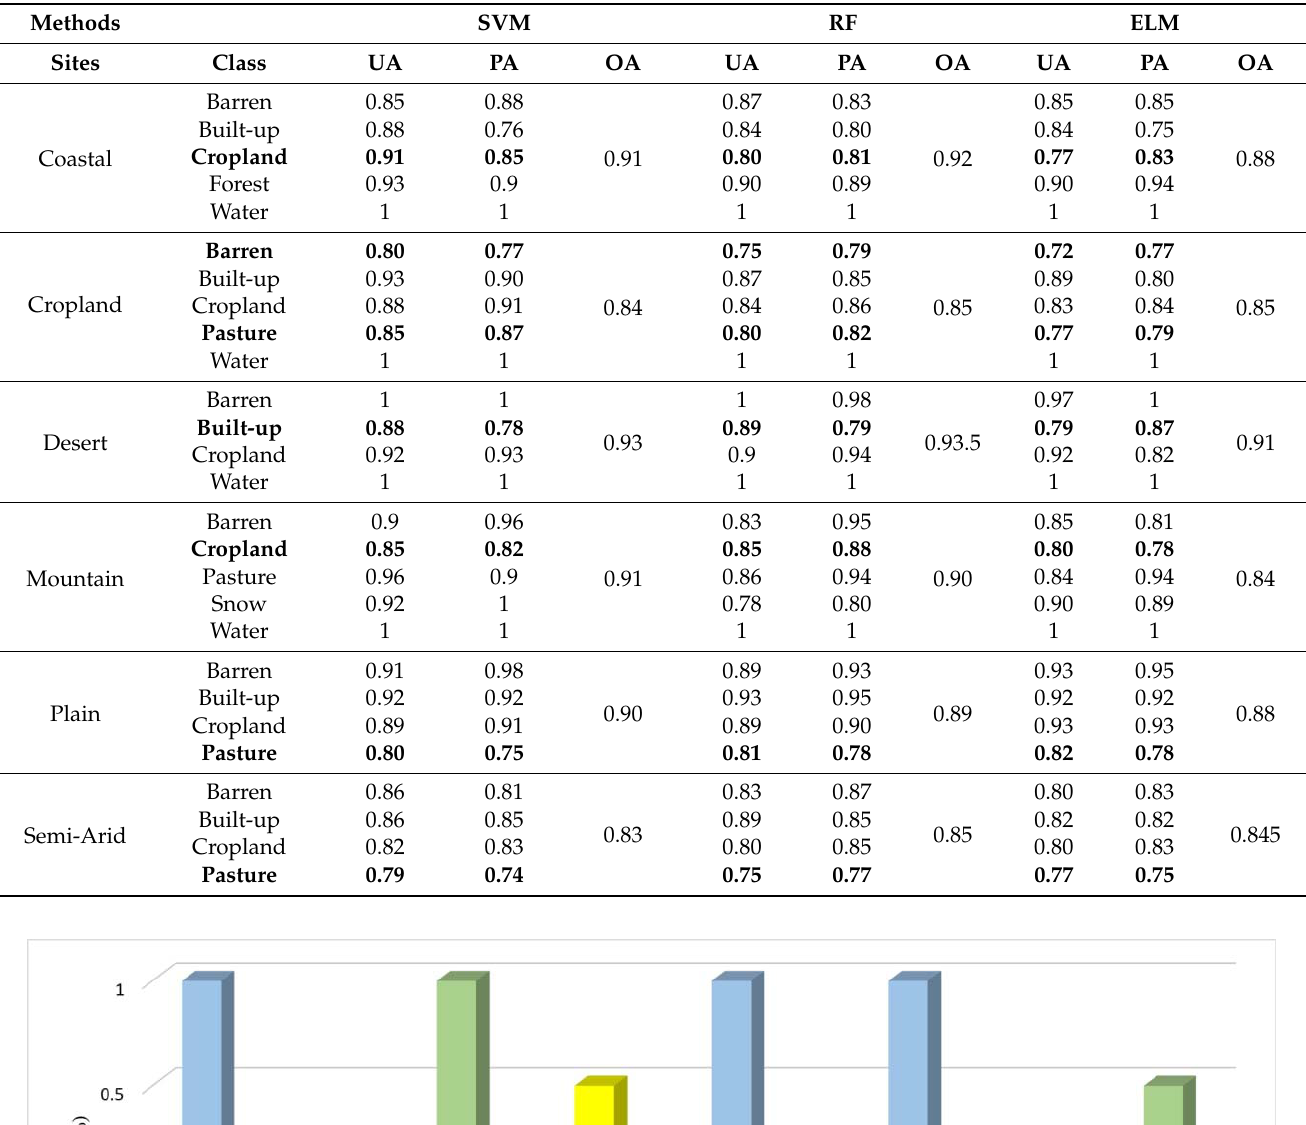
Table 6. The result of accuracy assessment methods in six different landscapes (after adopting G-SMOTE). Minority classes for each landscape are highlighted.